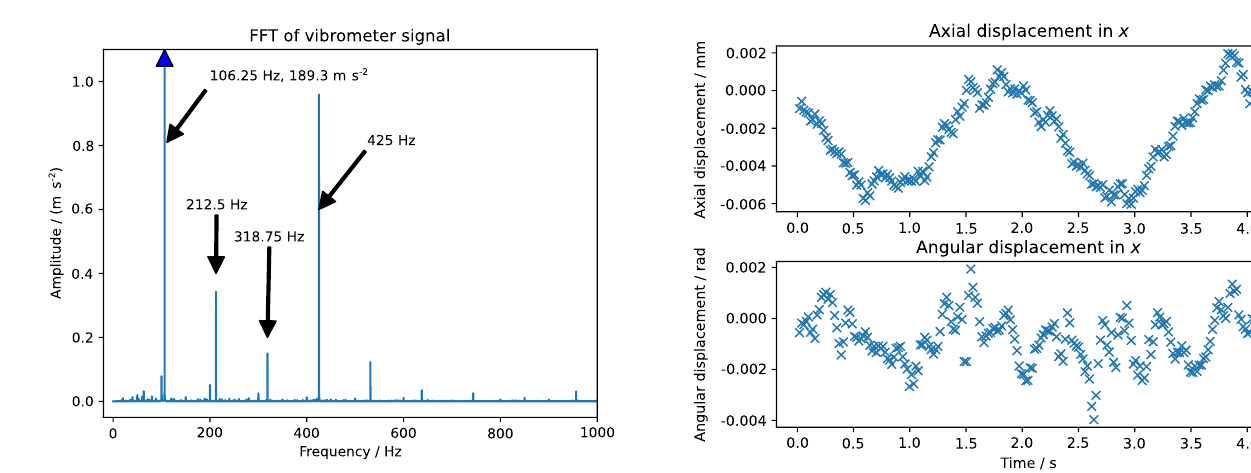
Figure 9. Axial and angular displacement in x